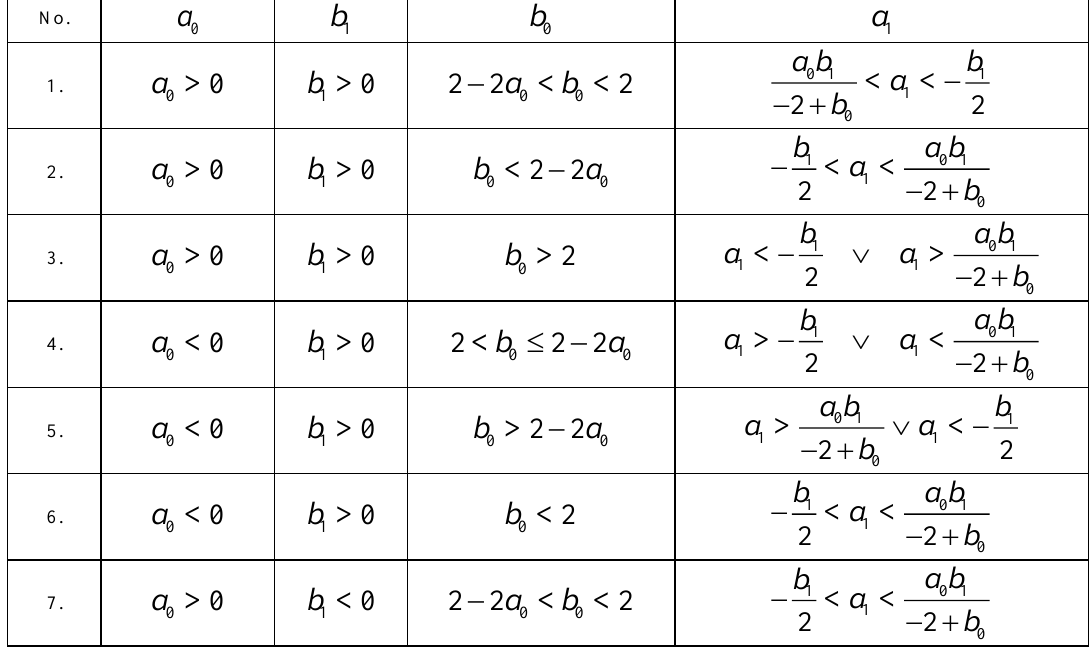
Table 1. The conditions for the value of the parameters so that the determinant of H is positive